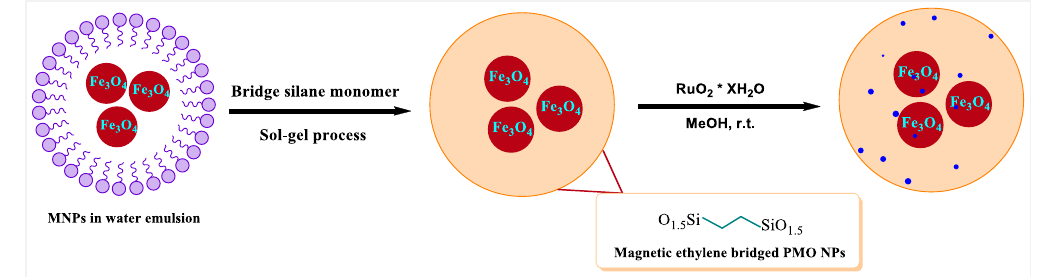
Scheme 2. Preparation of the Ru@M-Ethylene PMO NP catalytic